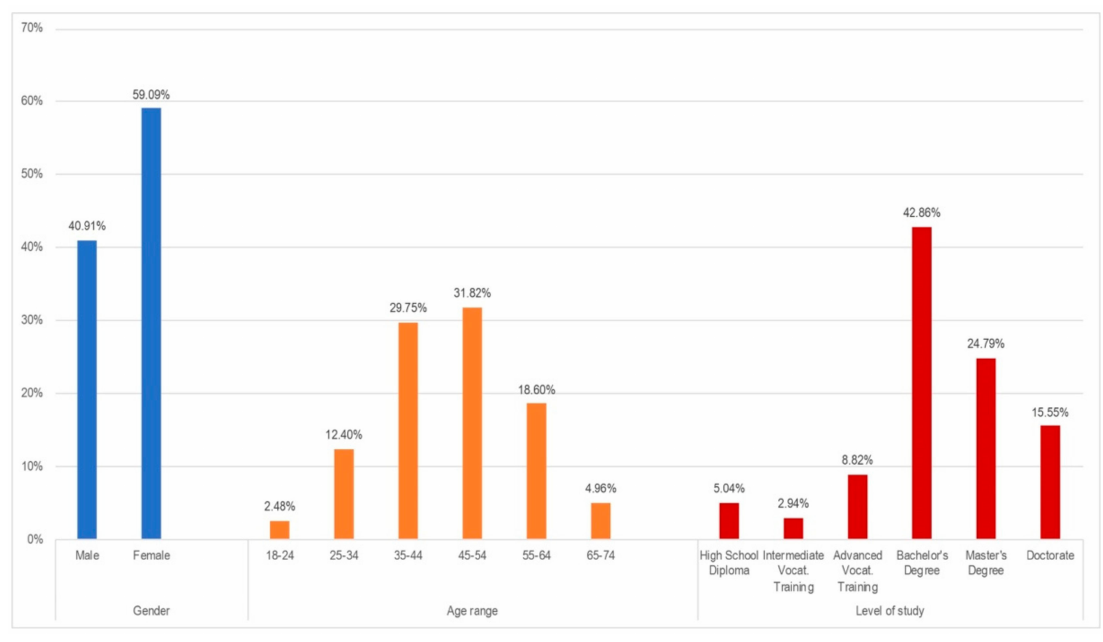
Figure 7. Distribution of qualitative participation by gender, age range, and